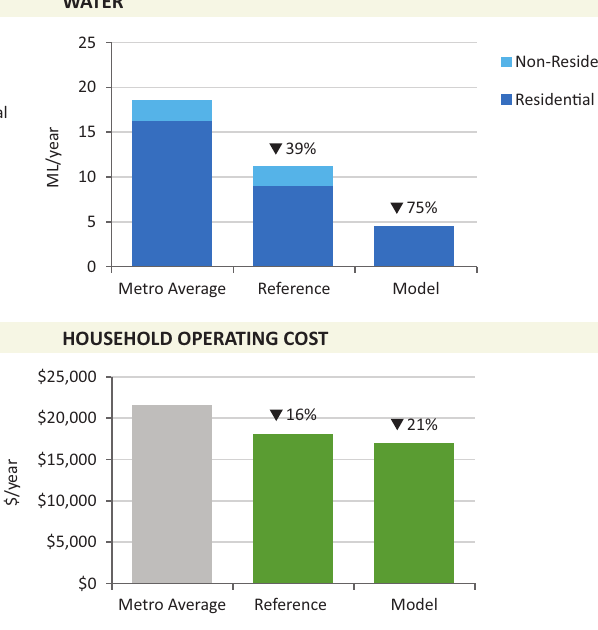
Figure 5. Results of early scenario modelling on WGV. meet net zero energy, assuming the homes are operated as intended as early data shows between 72% and 98% of the power needs will be met from the solar and bat- teries. Thus, with the solar energy being exported to the grid (once batteries are filled) this means more renew- ables are being produced than energy